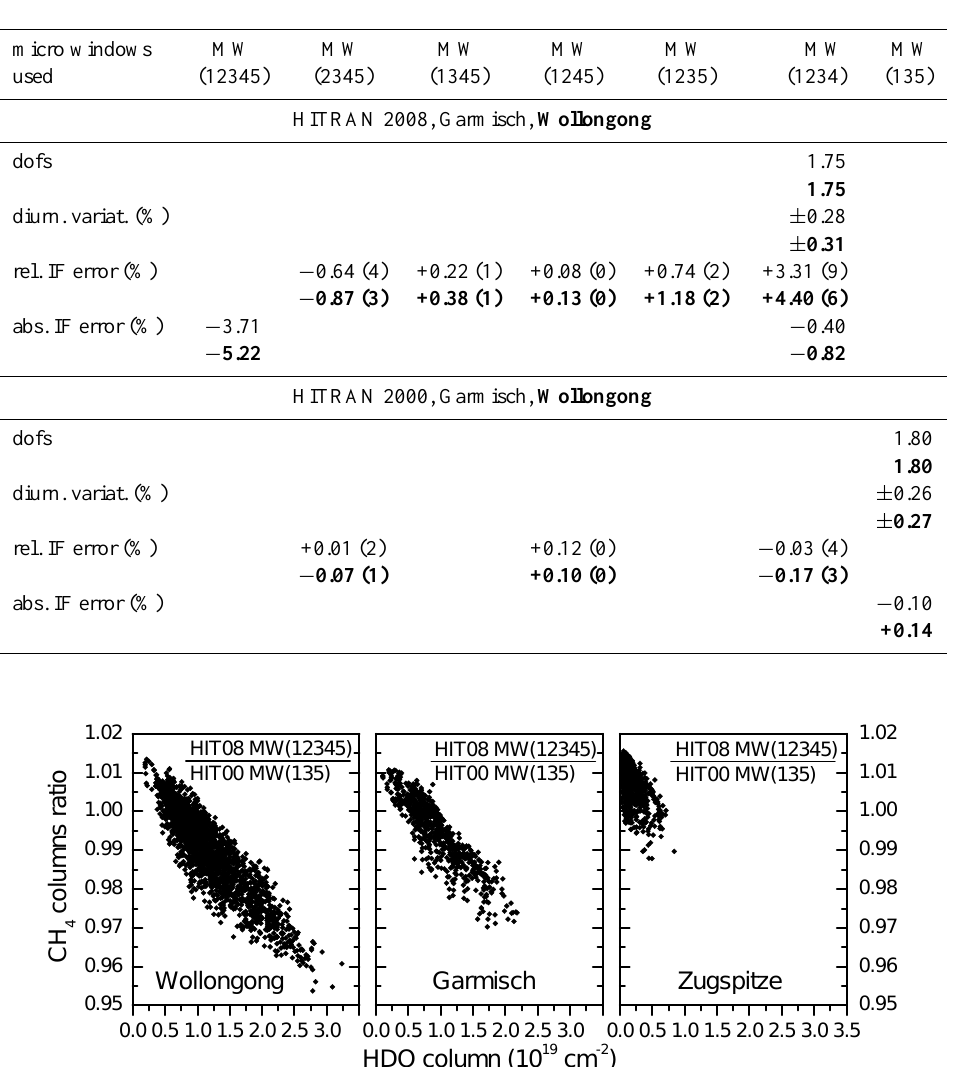
Table 6. Comparison of the HIT08 MW (12345) and HIT08 MW (1234) retrieval strategies versus the recommended strategy HIT00 MW (135). Numbers are for Garmisch (standard font) and Wollongong (bold). Use of HIT08 MW (12345) is out of discussion (Wollongong absolute interference error − 5.22%) but also the use of the HIT08 MW (1234) strategy is strongly discouraged because of i) high absolute interference errors (e.g. − 0.82% for Wollongong) and (ii) strong “internal tension” (strong rel. interference error contributions from differing micro windows with opposite sign, e.g. − 0.87% versus +1.18% for Wollongong).